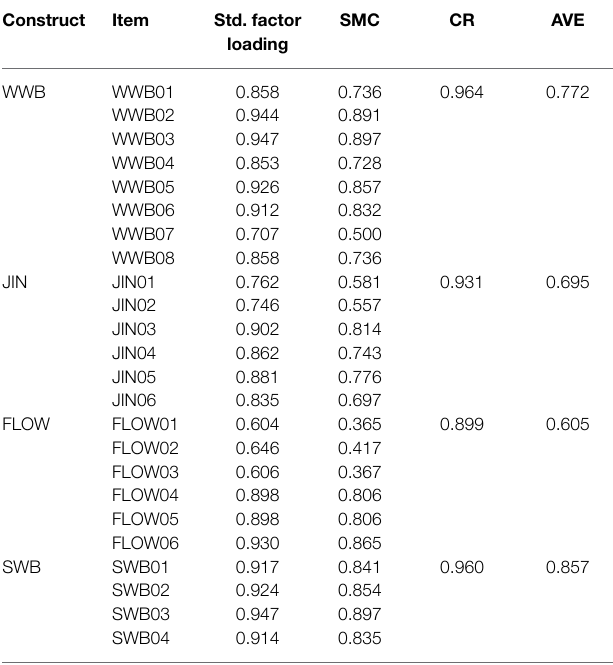
TABLE 5 | Analysis results of the measurement model. Construct Item